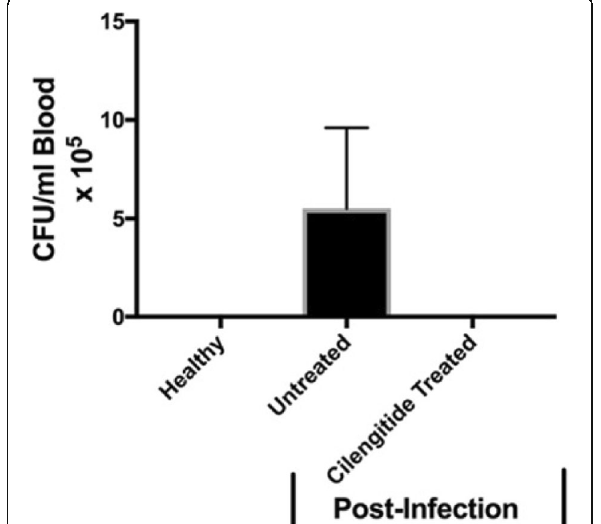
Fig. 1 (abstract P40). See text for description